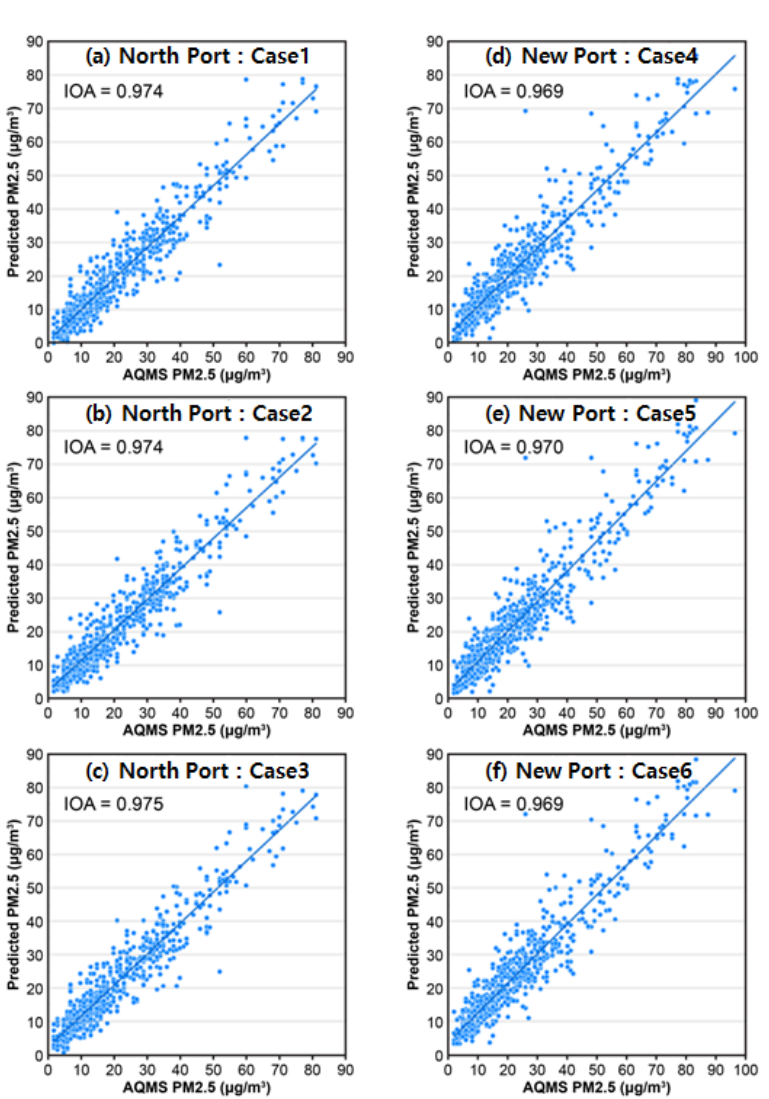
Figure 4. Scatter plot of observation and prediction results for PM 2.5 . ( a , d ) AQMS + ASOS, ( b , e ) AQMS + ASOS + all an- chored ships, ( c , f ) AQMS + ASOS + anchored ships over 2000